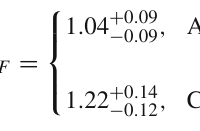
Fig. 4 μ ggF signalstrength(upperpanel)and δ m 2 rection (lower panel) shown as a scatter plot in the (α 1 ,α 2 ) plan within the TRSM. Inputs as in Fig.